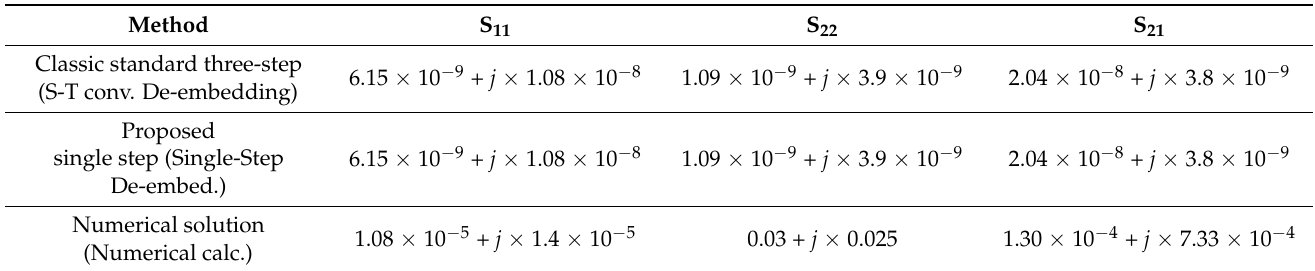
Table 1. Maximum absolute error for the de-embedding methods considered.